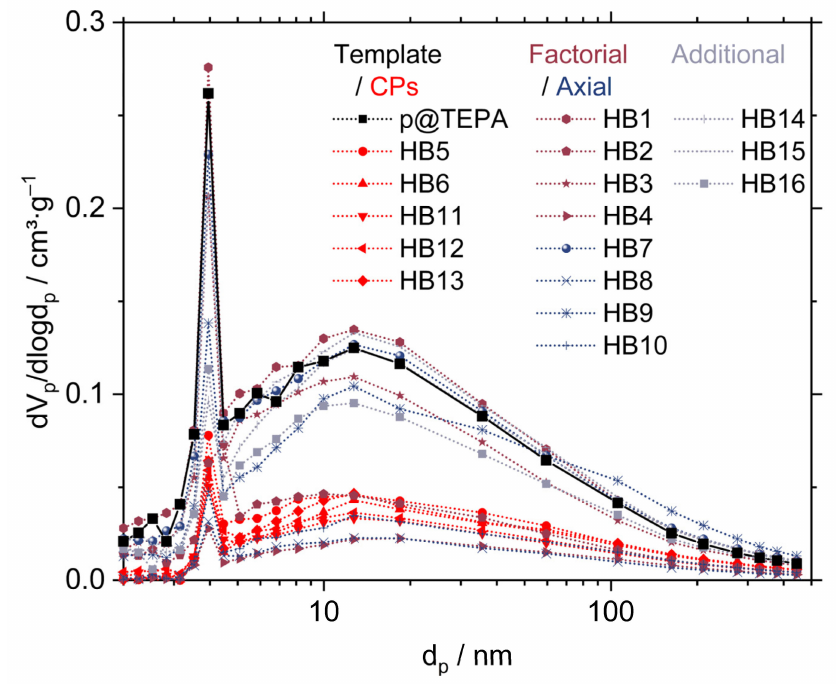
Figure 3. Pore size distribution of the porous p@TEPA template (solid line) and porous HBs (dotted lines). The template is shown in black, factorial design points are shown in dark red, center points (CPs) are shown in red, axial design points are shown in blue and additional design points are shown in